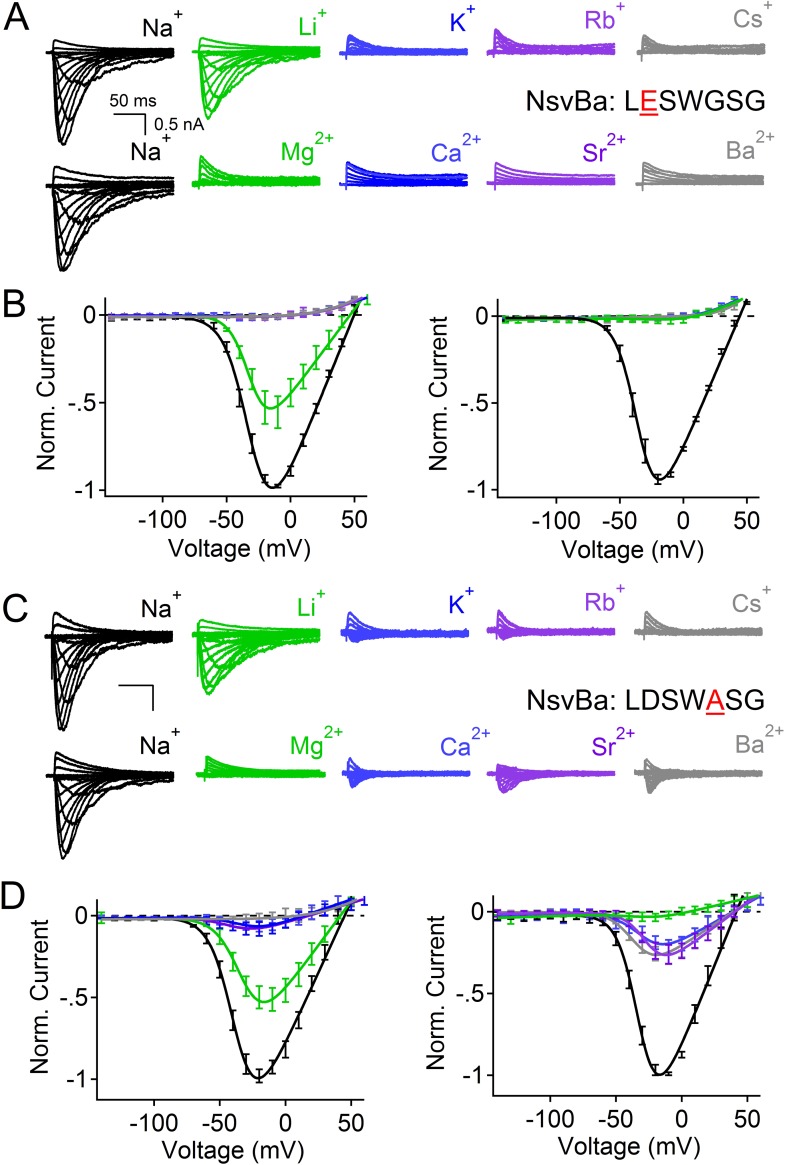
The effects of the single mutations D186E and G189A in the NsvBa selectivity filter.(A and C) Representative current traces recorded from the NsvBa selectivity filter mutations D186E (sequence TLESWGSG) and G189A (sequence TLDSWASG) in response to 10 mV depolarizing activation steps from −140 mV in (top) monovalent or (bottom) divalent extracellular conditions. (B and D) Resulting current–voltage relationships measured for the mono- (150 mM) or divalent (110 mM) conditions. Current amplitudes are normalized to either the maximum inward current recorded in the 150 mM or 110 mM Na+ condition (n = 4–9 cells for both channels, Error = ±SEM).